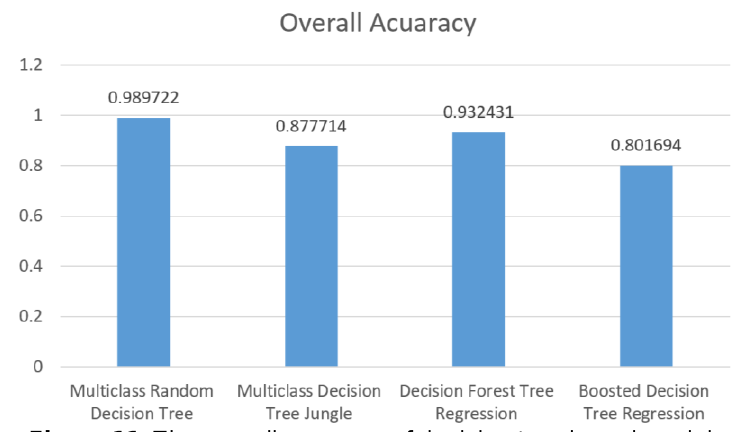
Figure 11. The overall accuracy of decision tree-based